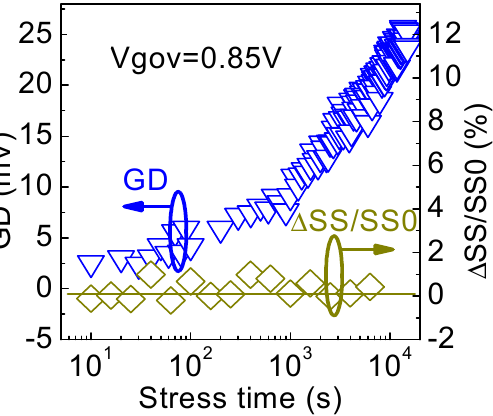
Figure 35. Under positive gate bias, generated defects (GDs) increased, but the negligible change in subthreshold swing (SS) indicates that interface states were not created [39].